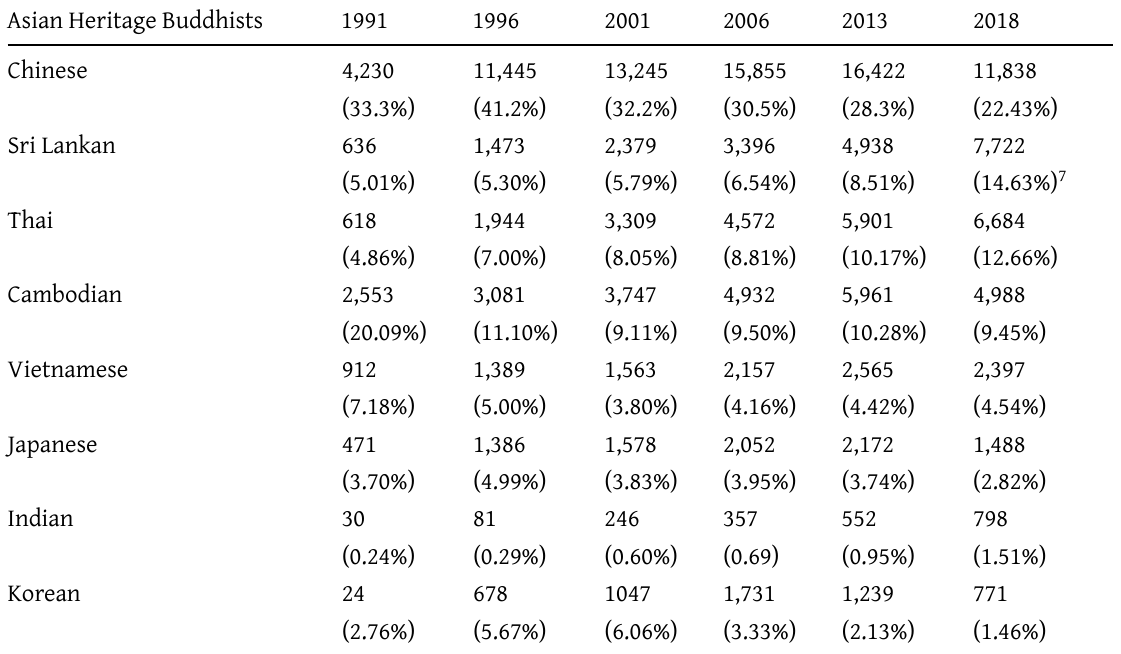
Table 2: Heritage Buddhist Population in New Zealand according to representative Ethnic Groups, 1991–2018. [Note: percentages indicate the proportion of Buddhists in New Zealand represented by the ethnic